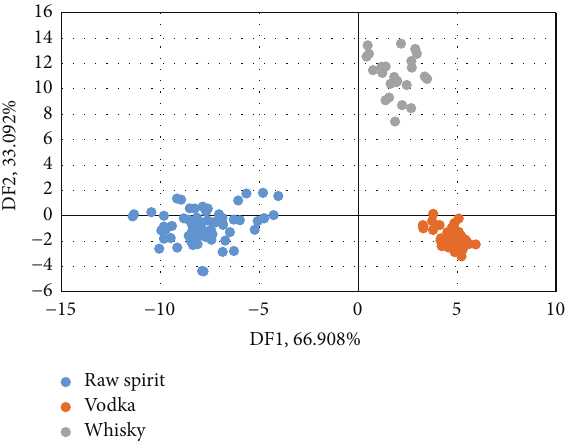
Figure 3: DFA of vodkas, whiskies, and raw spirits. the similarity parameter set at 90%. Compounds present in the sample were identified on the basis of comparison of